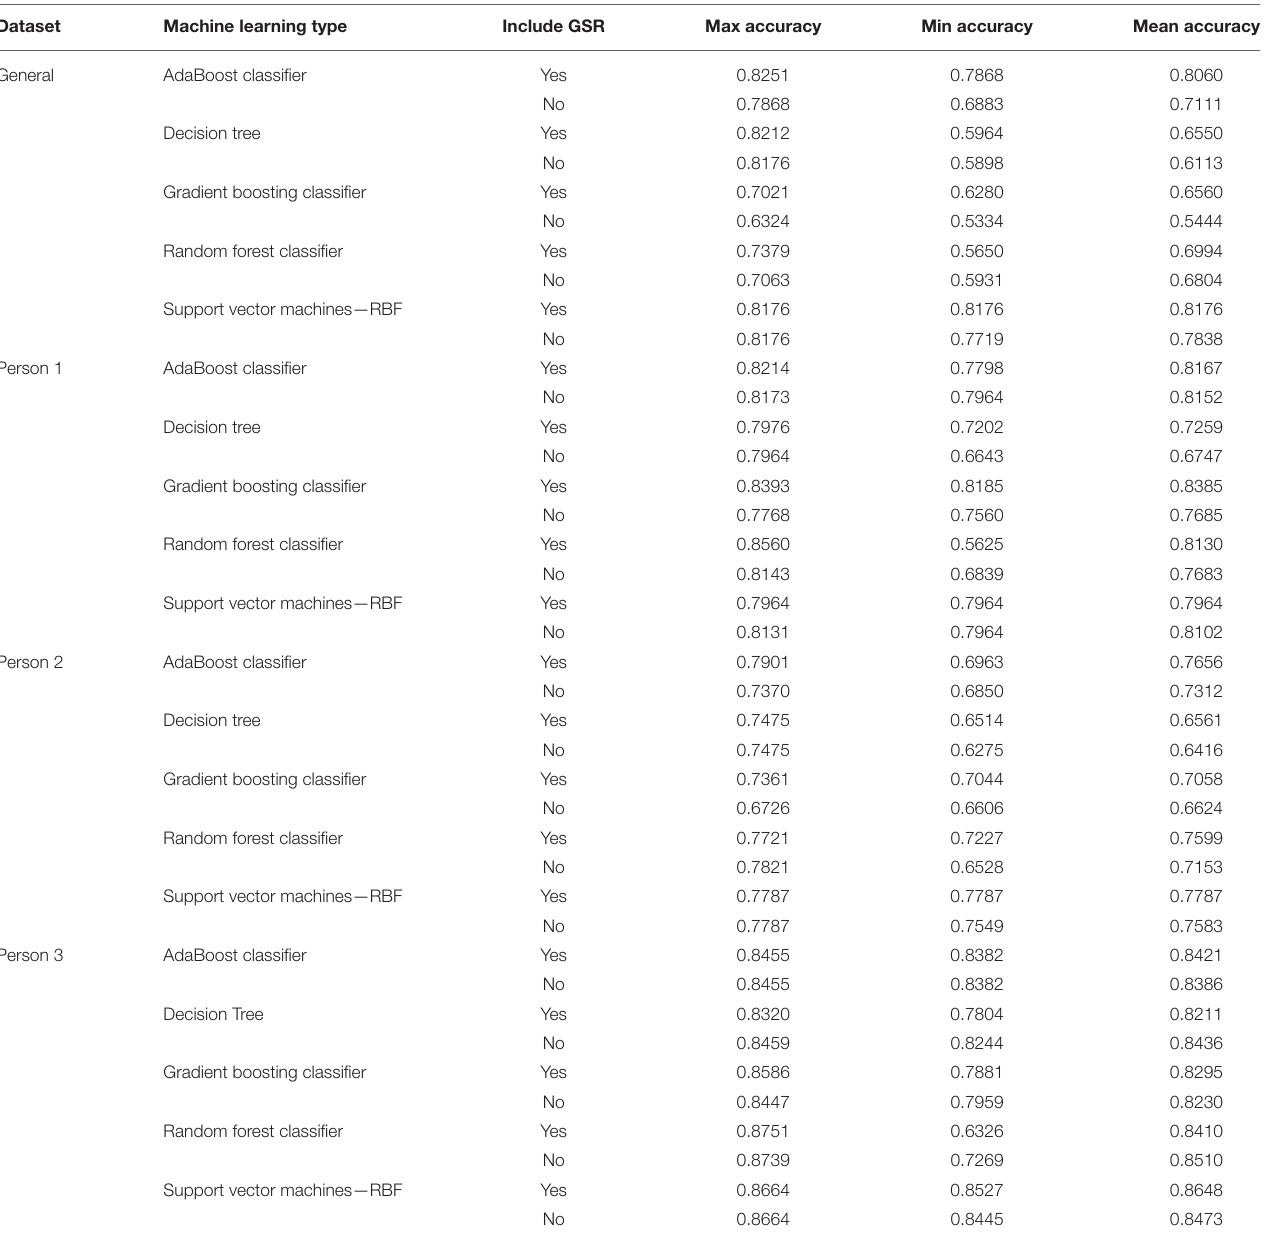
TABLE 8 | Details of the performance review of machine learning for all the